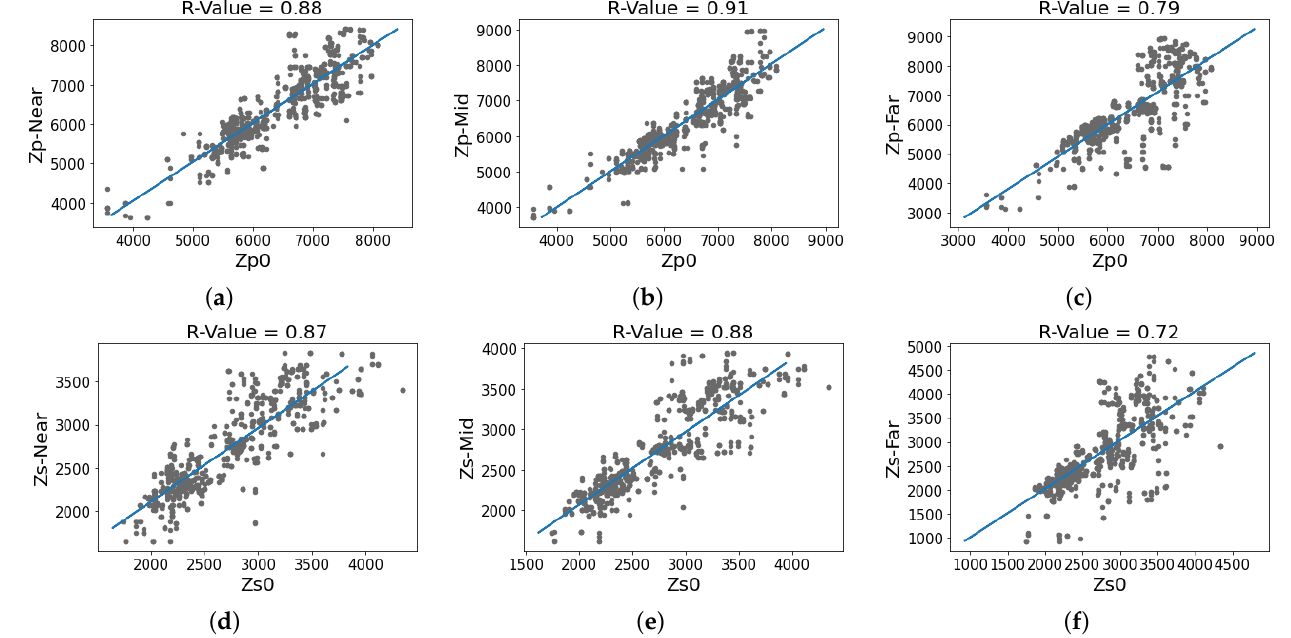
Figure 3. Plots of the zero-offset P-impedance ( Z P 0 ) versus each of the partially inverted P- impedances ( a ) Z p -Near, ( b ) Z p -Mid, and ( c ) Z p -Far, while the zero-offset S-impedance ( Z S 0 ) is plotted versus each of the partially inverted S-impedances ( d ) Z s -Near, ( e ) Z s -Mid, and ( f ) Z s -Far. The linearity between variables is proven visually through the best-fit lines (in